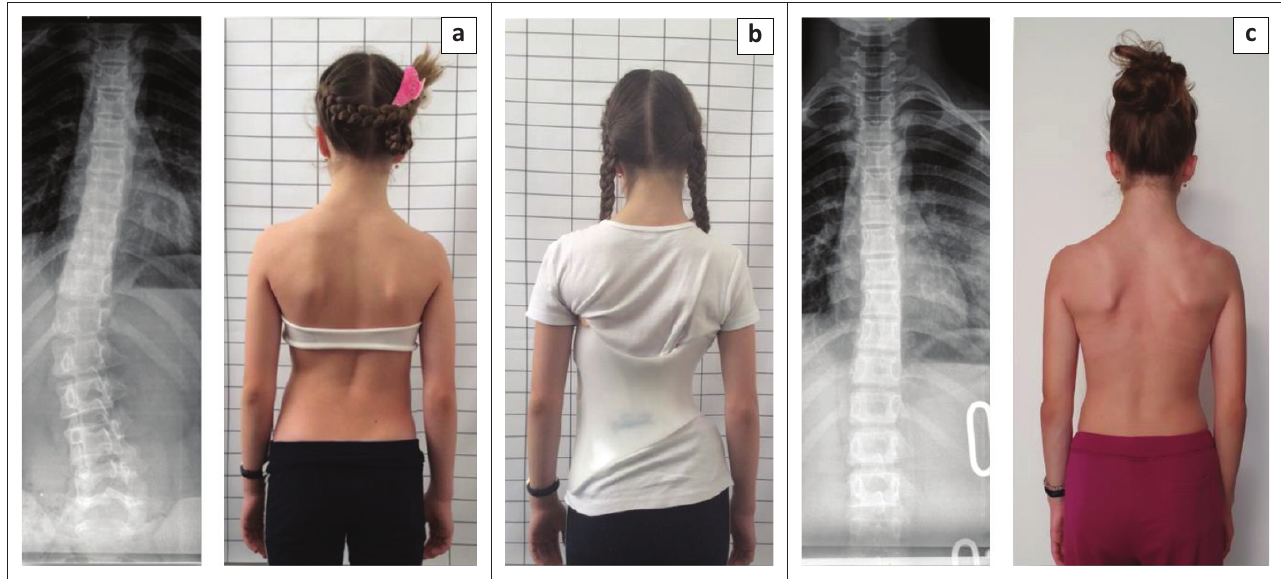
FIGURE 2: (a) Immature patient with a thoracolumbar curve pattern without the brace, (b) with a good in-brace correction in a Chêneau style brace and (c) a good clinical appearance after 9 months of treatment.